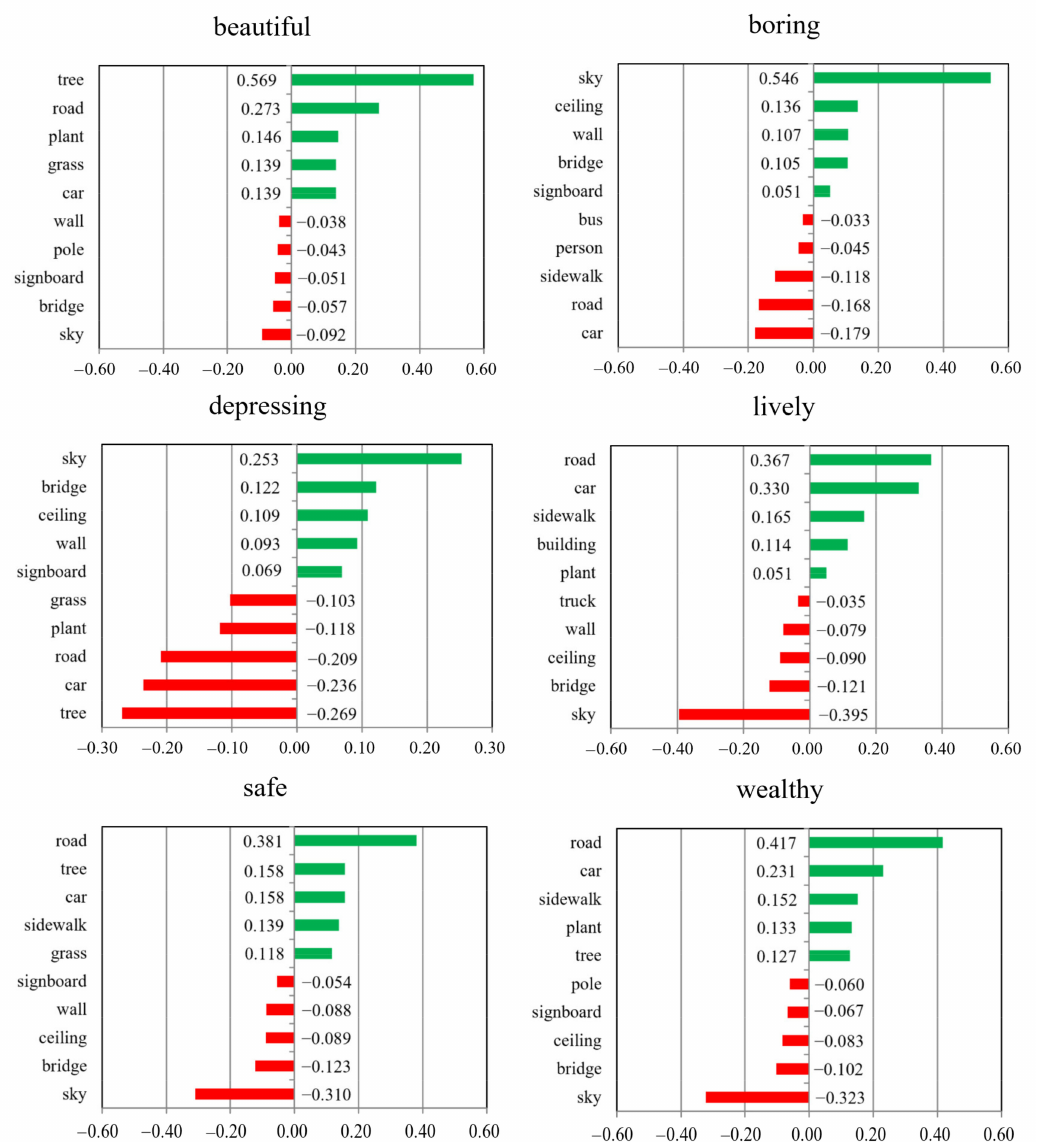
Figure 12. Results of the multiple linear regression analysis between the visual elements and the perception